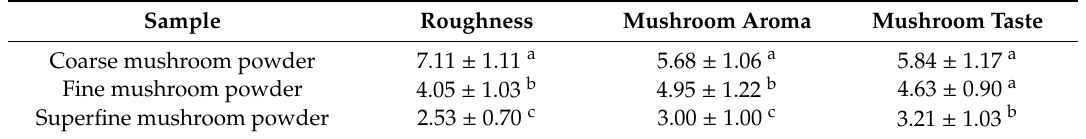
Table 5. Sensory properties of coarse, fine and superfine mushroom powders produced from white button mushrooms exposed to a 30 min UV-B